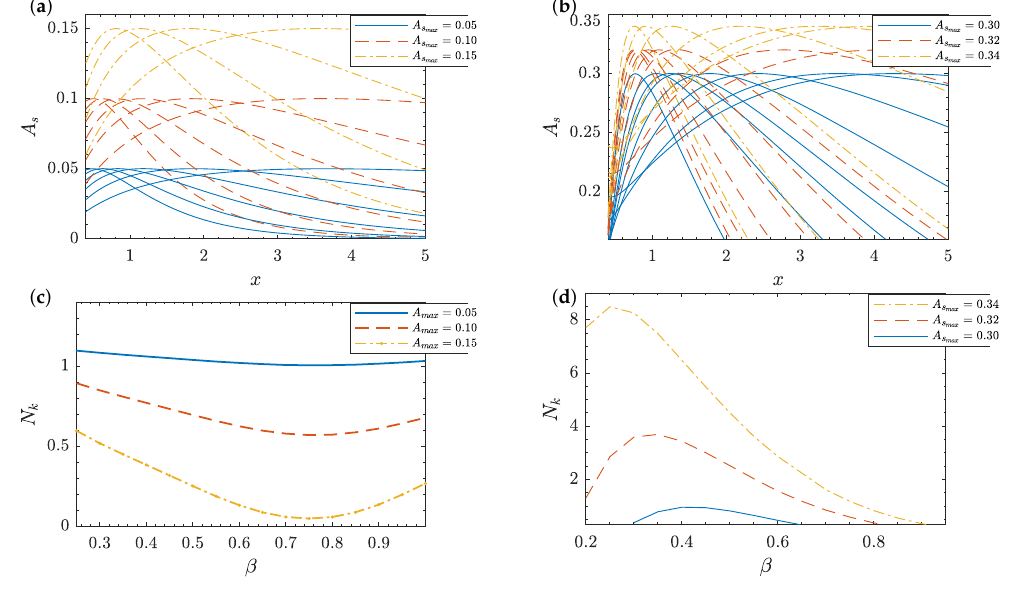
Figure 5. ( a , b ) Evolution of β -family of streaks for several values of maximum streak intensity. Effect of wavenumber β on N -factor over ( c ) TS waves and ( d )